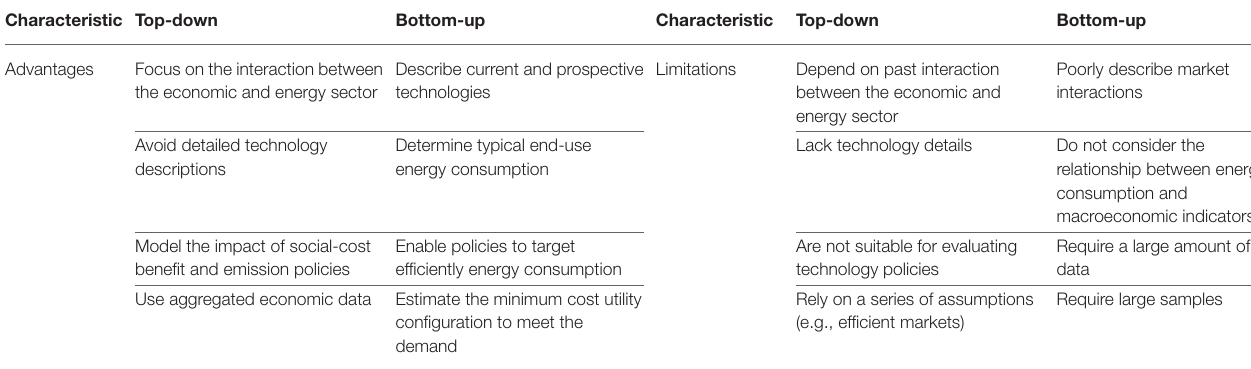
TABLE 1 | Advantages and limitations of bottom-up and top-down approaches. Characteristic Top-down Bottom-up Characteristic Top-down